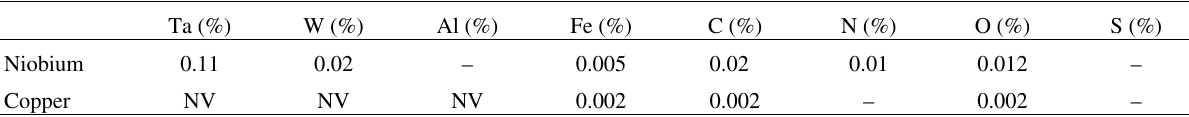
Figure 2. Processing route of Cu-Nb wires manufacture. Table 1. Chemical composition of niobium and